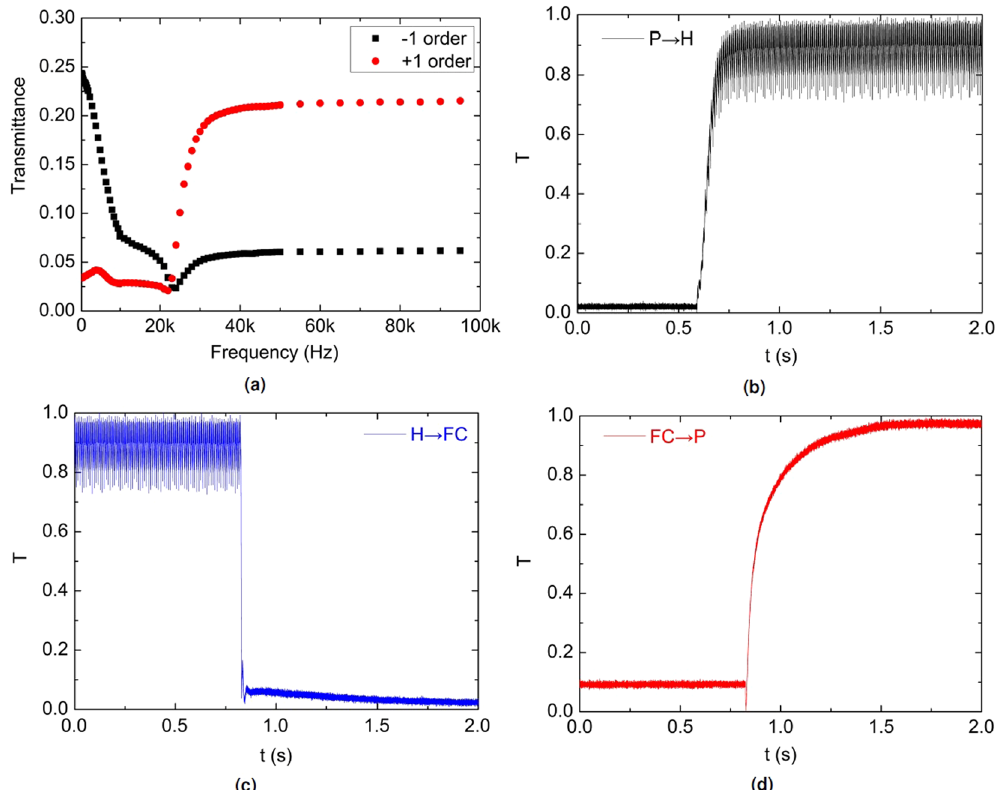
Figure 6. The switching behaviour of DFCh-LC-grating beam steering devices between different states: ( a ) transmittance versus applied frequency; ( b ) switching from P to H; ( c ) switching from H to FC; ( d ) switching from FC to